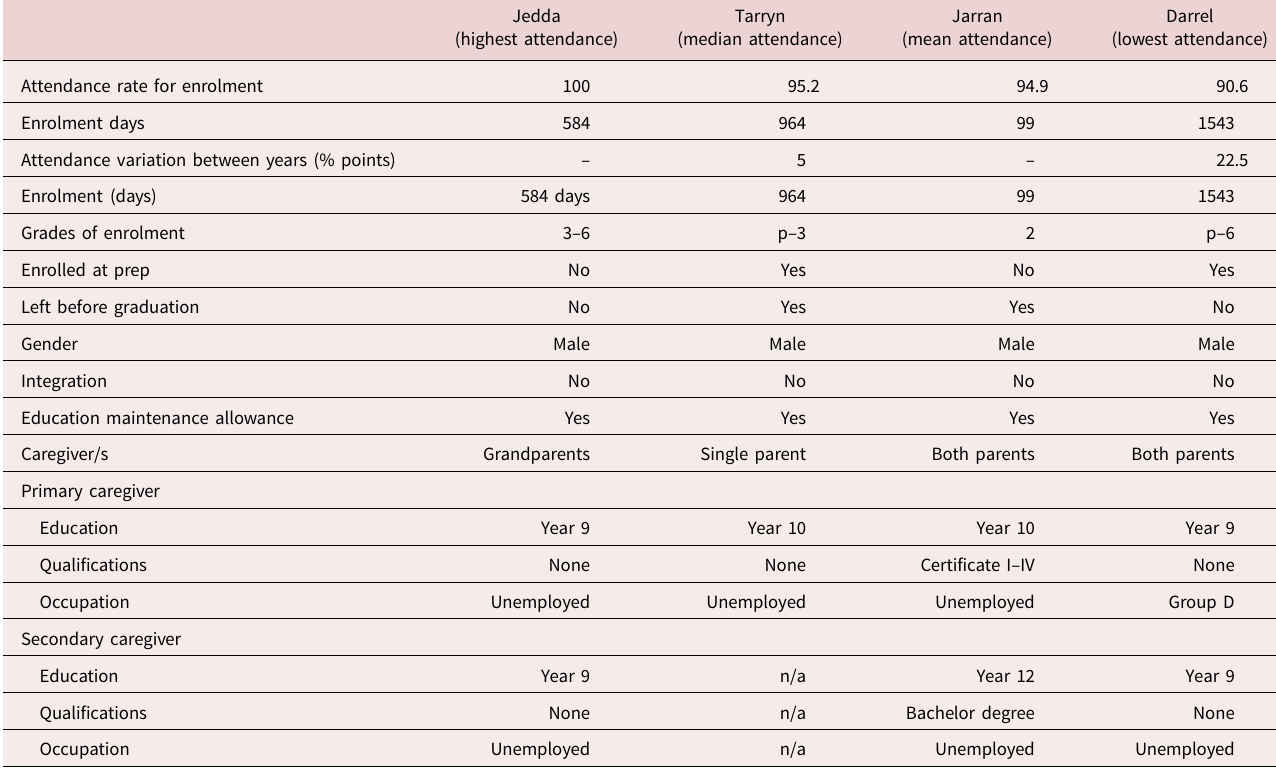
Table 2. Characteristics of Watney ’ s high-attending students (using pseudonyms) whose attendance over the period of their enrolment represents the highest, median, mean and lowest attendance rates